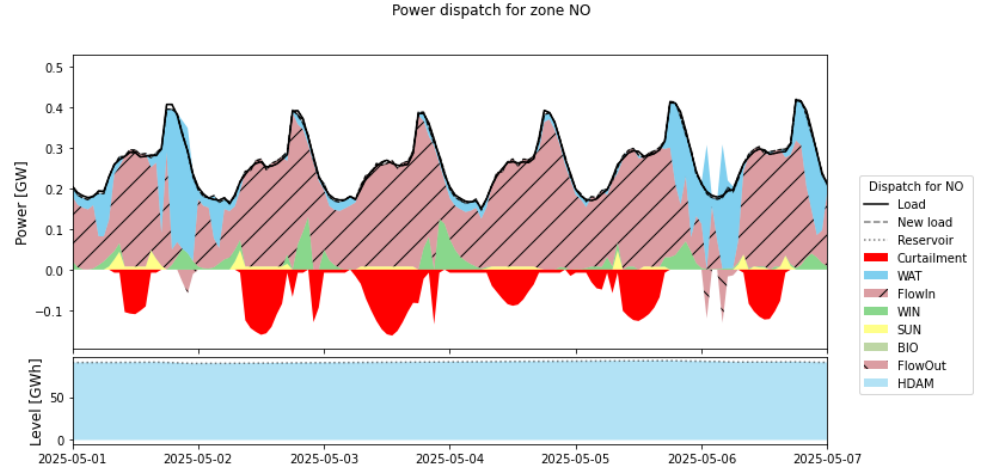
Figure 23. Very-High-Penetration Scenario 10(H)—North zone (1–7 May